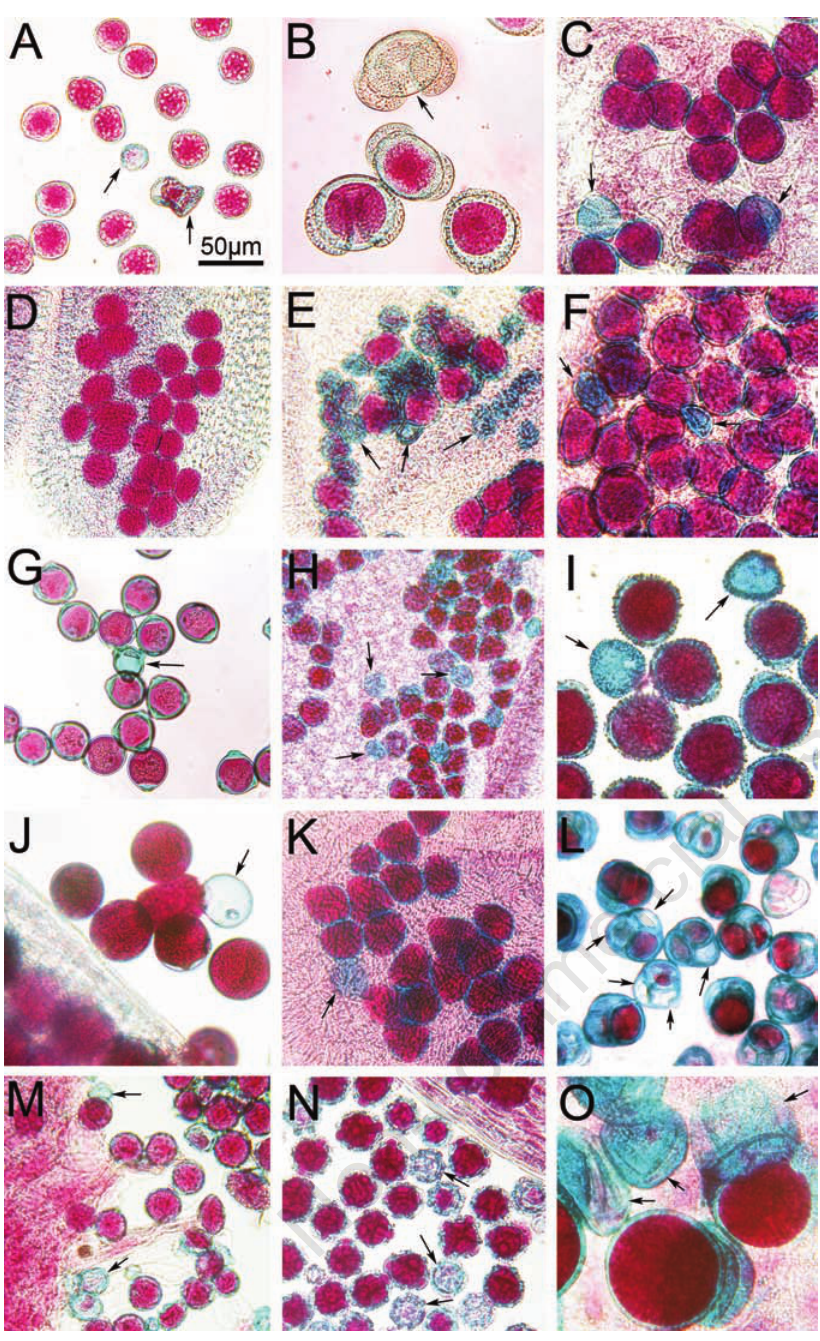
Figure 1. Differential staining of aborted and non-aborted pollen grains. (A) Ginkgo bilo- ba . (B) Pinus resinosa . (C) Acer rubrum , stained without phenol. (D) Arabidopsis thaliana L er (diploid). (E) Arabidopsis thaliana L er (autotetraploid). (F) Acer rubrum , stained with phenol. (G) Betula populifolia . (H) Fragaria versca (Rugen). (I) Lonicera tatarica . (J) Oryza sativa . (K) Prunus padus . (L) Rhododendron mucronulatum . (M) Solanum lycopersicum (Microtom). (N) Taraxacum officinale . (O) Tulipa spp . Bar=50 m m, all images are at the same magnification. Arrows indicate aborted pollen grains that stained blue-green. Non-aborted pollen grains are stained